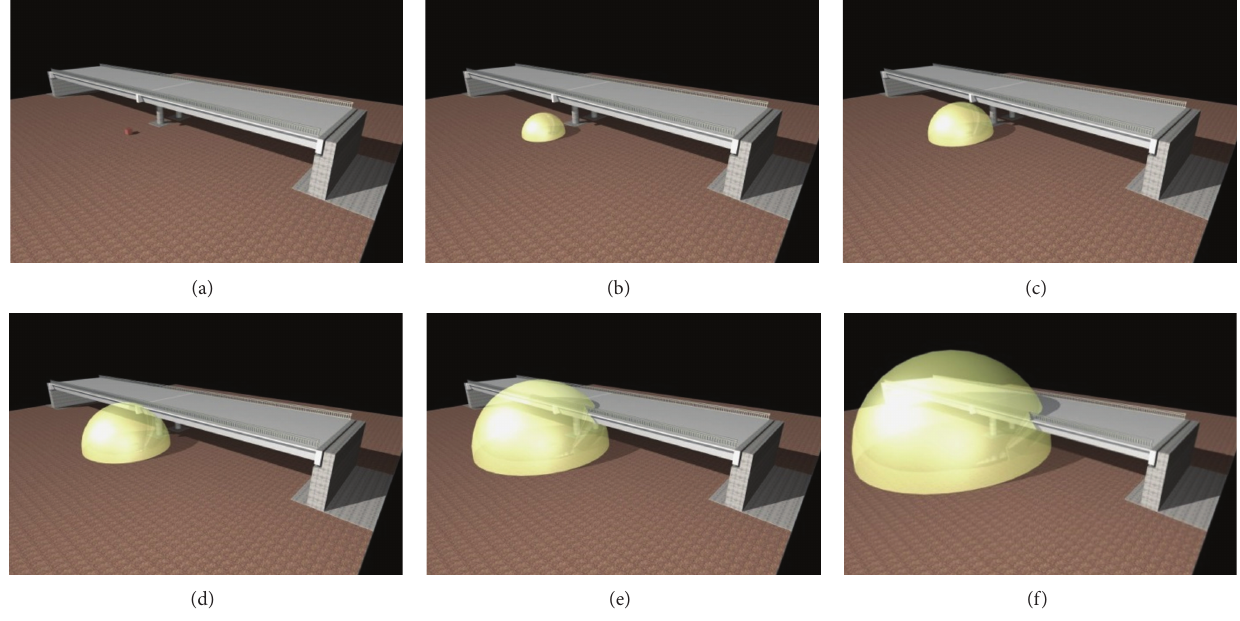
Figure 6: Schematic representation of contact of the blast wave with the bridge